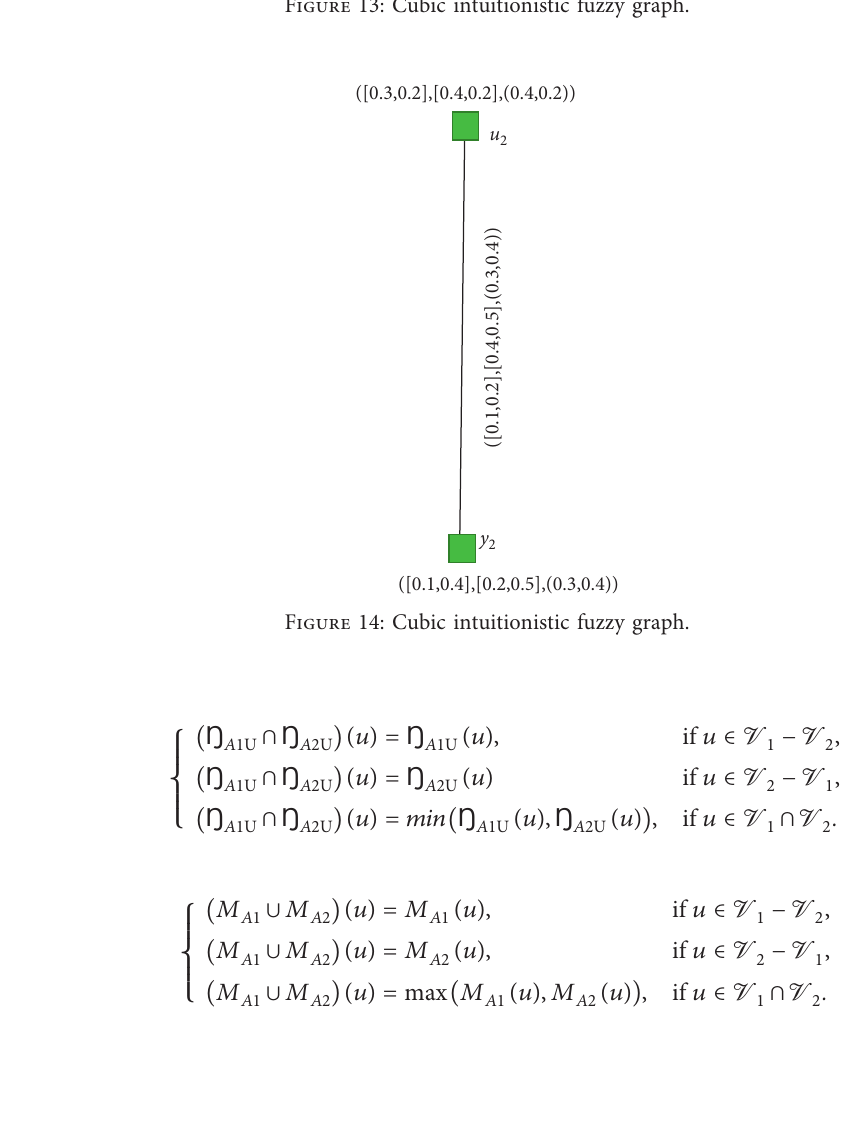
Figure 13: Cubic intuitionistic fuzzy graph.